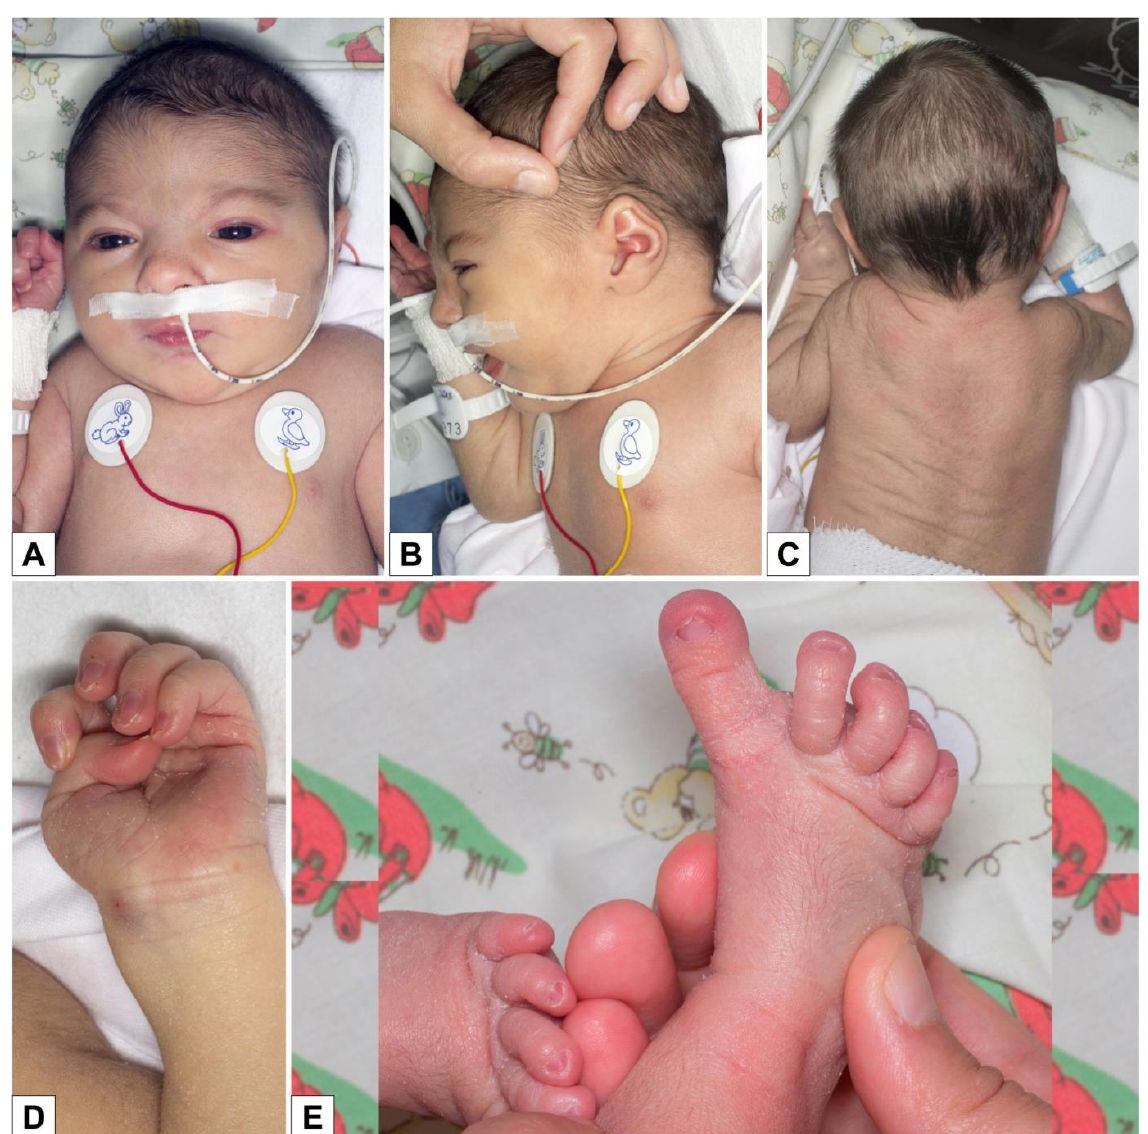
Figure 1. Clinical features at 1 week: facial dysmorphism ( A , B ), mild hypertrichosis of the back ( C ), adducted thumb ( D ), and long toe ( E